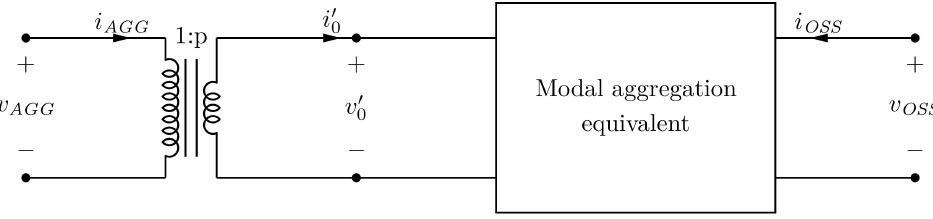
Figure 3. Modal transformer model.